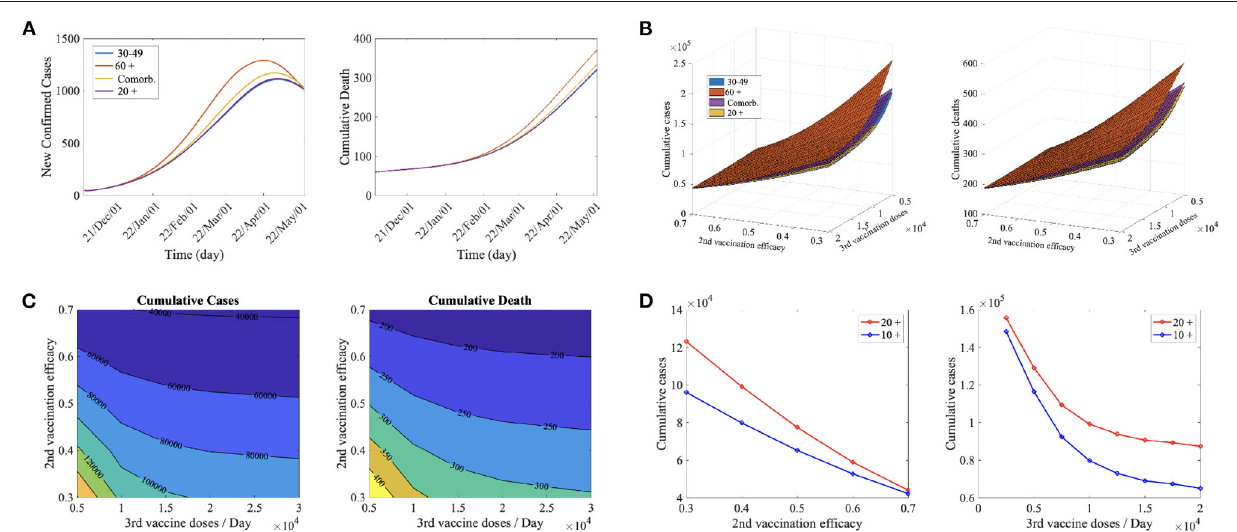
FIGURE 4 | (A) Time series of confirmed cased and cumulative deaths for the priority vaccination policies (30–49, 60+, Comorb., 20 +) for the second vaccine efficacy, τ 2 = 0.4, and daily the third vaccine dose, ν B = 10,000. (B) Cumulative confirmed cases and cumulative deaths for the priority vaccination policies (30–49, 60+, Comorb., 20 +) for ν B = 5,000, ...,20,000, and τ 2 = 0.3,...,0.7. (C) Cumulative confirmed cases and cumulative deaths for the priority vaccination on those aged 30–49 years for ν B = 5,000, ...,20,000, τ 2 = 0.3,...,0.7. (D) Comparison of cumulative confirmed cases for vaccination on 20 years and older (20 +) and 10 years and older (10 +) for (left) τ 2 = 0.3,...,0.7, ν B = 10,000 and (right) τ 2 = 0.4, ν B = 2,500,